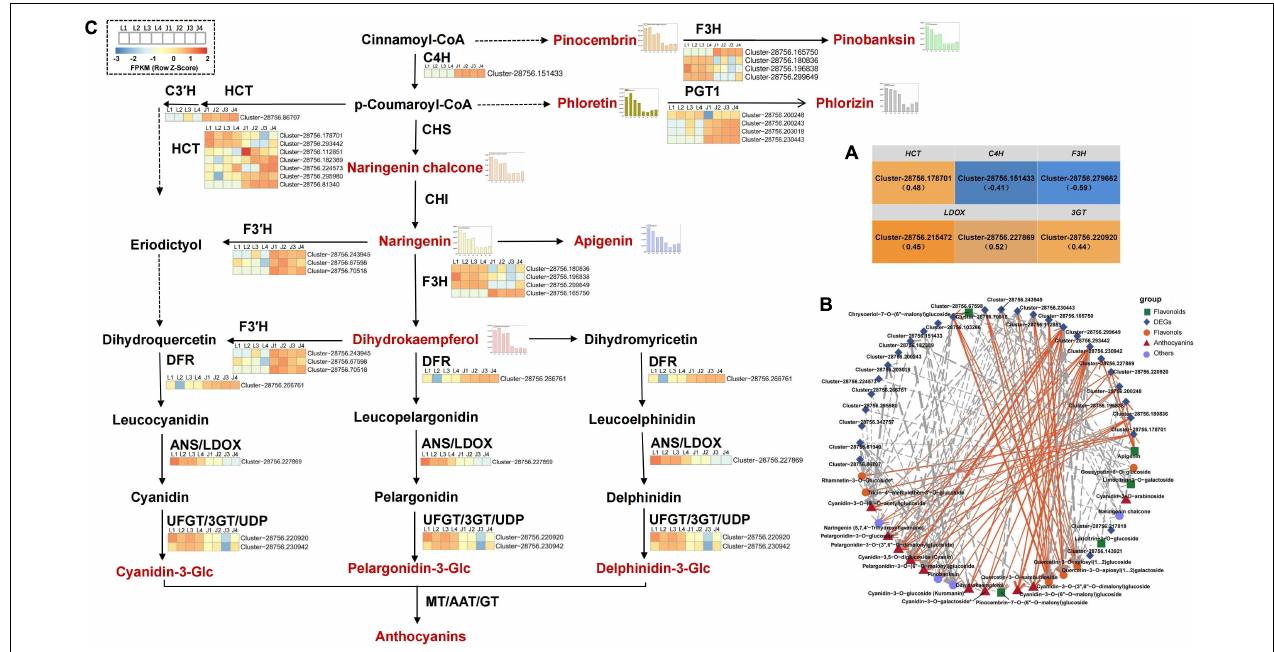
FIGURE 3 | DEGs analysis of flavonoid and anthocyanin synthesis in C. tinctoria. (A) Six DEGs correlated with total flavonoids content. The brackets indicated the correlation coefficient ρ . (B) There was a significant correlation between 28 DEGs and 25 DAFs ( P < 0.01, | ρ | > 0.80). The solid line indicates the positive correlation, the dotted line indicates the negative correlation, and the thickness of the line indicates the correlation strength. (C) The 28 DEGs (in B ) involved in flavonoid and anthocyanin biosynthesis pathway of LS and JS. C 3 (cid:48) H , coumaroylquinate 3 (cid:48) -monooxygenase; C 4 H , trans-cinnamate 4-monooxygenase; HCT , shikimate O-hydroxycinnamoyltransferase; PGT 1, phlorizin synthase; F 3 H , naringenin 3-dioxygenase; F 3 (cid:48) H , flavonoid 3 (cid:48) -monooxygenase; DFR , bifunctional dihydroflavonol 4-reductase; LDOX , leucoanthocyanidin dioxygenase; 3 GT , anthocyanidin 3-O-glucosyltransferase.